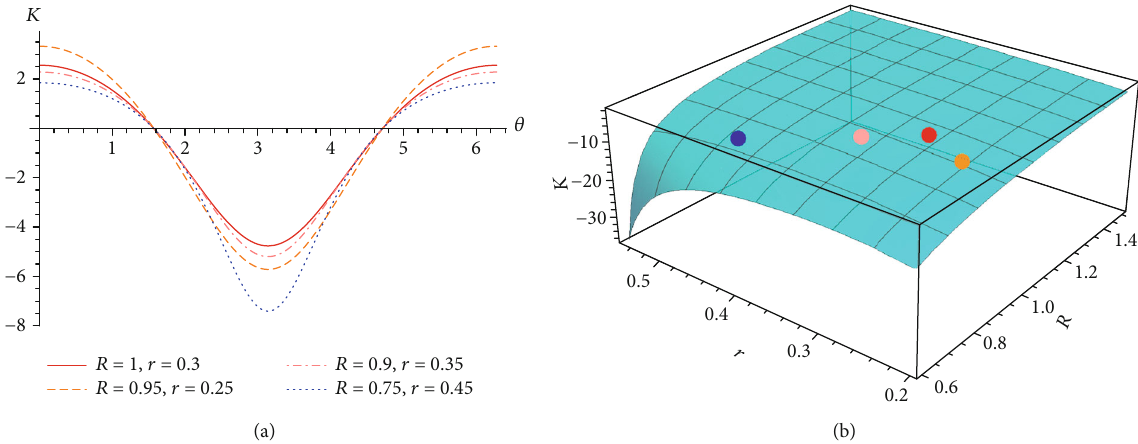
Figure 9: (a) Curvature as a function of θ for di ff erent values of radii. For certain values of R decreasing and r increasing, the minimum of K in π becomes more pronounced. (b) Curvature landscape for di ff erent radii at θ = π . The tori of di ff erent radii in the right fi gure are shown as points with the indicated color code.